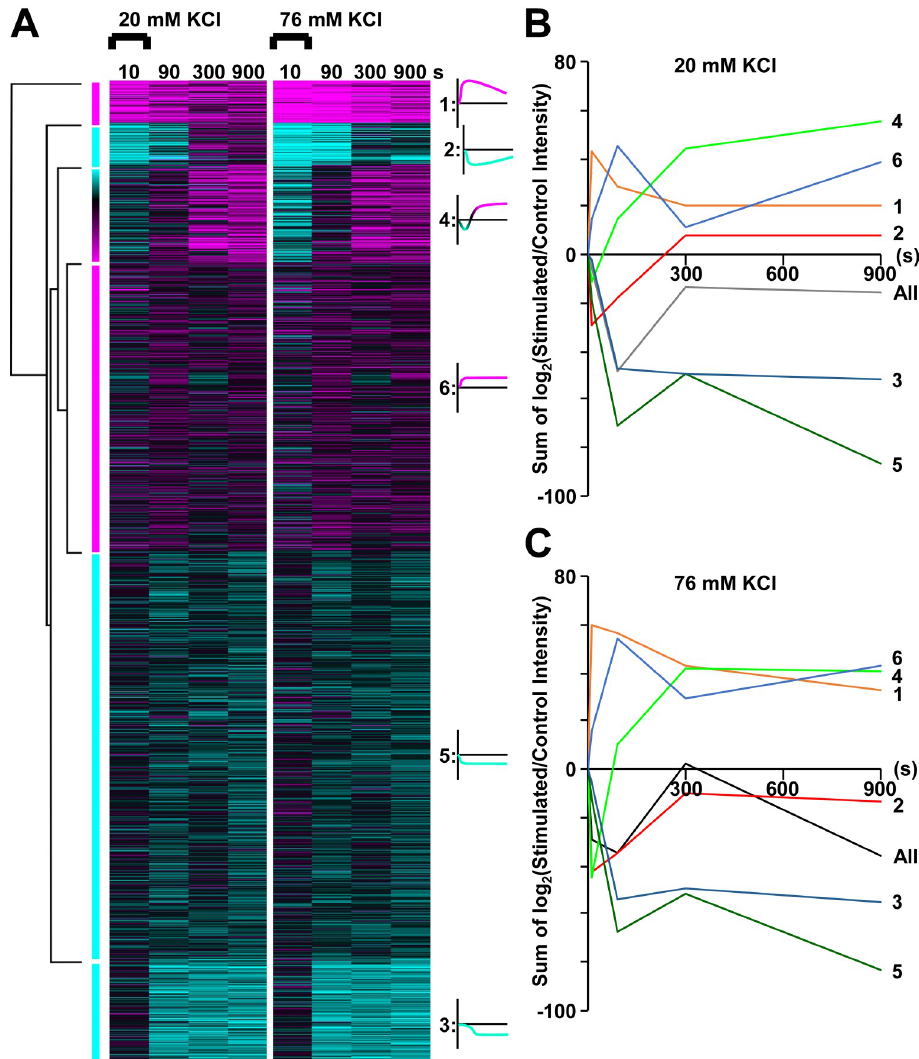
Fig 4. Clustering of temporally profiled phosphopeptides from synaptosomes stimulated at two KCl concentrations. (A) Heat map of k-means clustering of all 1,917 phosphopeptides for both 20 and 76 mM KCl experiments with at least one significant change at any time point. Log 2 (stimulated intensity/control intensity) is shown using the same colour scale as in Fig 2B. Dendrogram shown on the left. Representative line graph of each cluster shown on the right. (B-C) Graphs accurately depicting the sum of log2(stimulated intensity/control intensity) versus time for each of the six clusters are shown for 20 mM (B) and 76 mM (C) KCl stimulations. The data are the result of six independent experiments for each stimulation condition (20 mM and 76 mM KCl). Underlying data for this figure can be found in S1